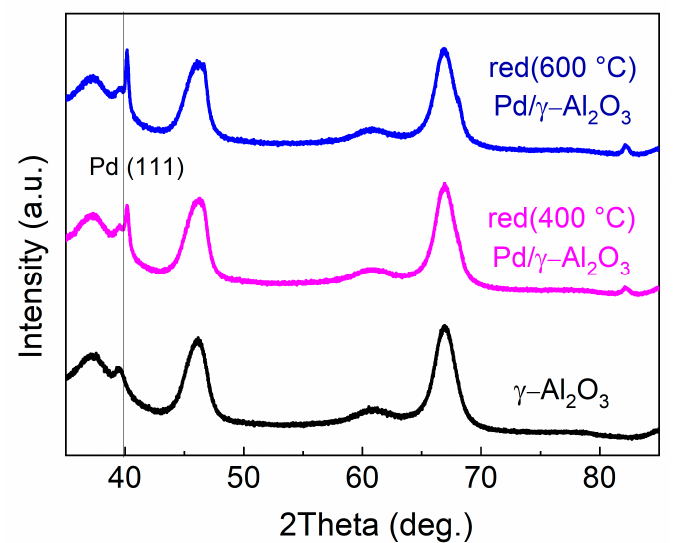
Figure 1. X-ray diffraction (XRD) pattern for γ -Al 2 O 3 and 1 wt.% Pd/ γ -Al 2 O 3 reduced at 400 °C and 600 °C.